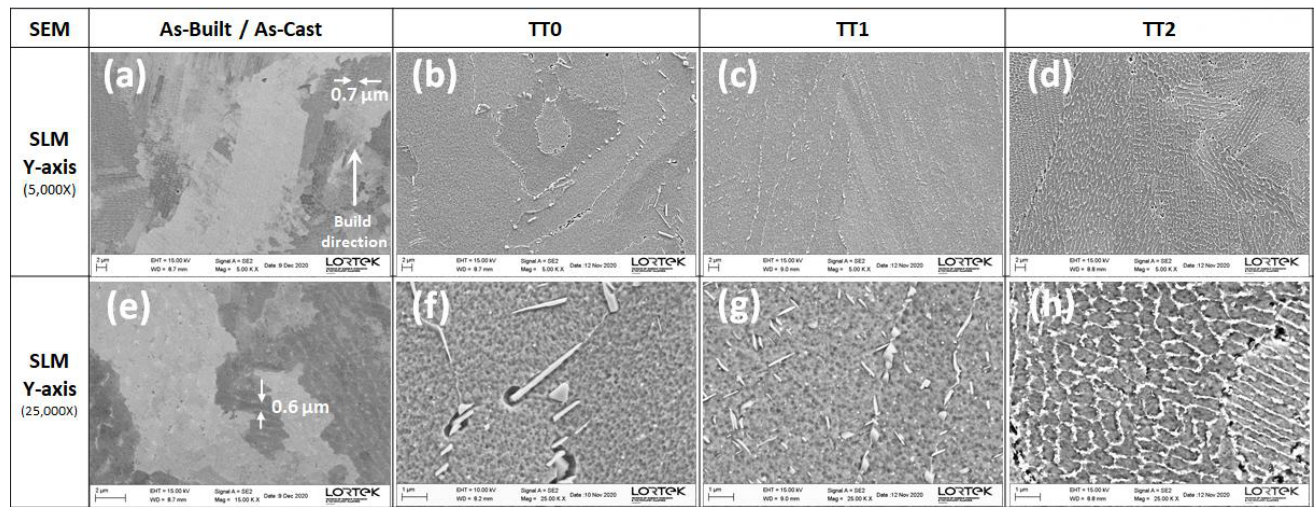
Figure 9. FESEM micrographs at different magnifications for IN718 SLMed in as-built and heat-treated conditions. ( a – d ): SLM samples in Y-axis, and ( e − h ): SLM samples in Z-axis. (all samples etched with Kalling Nº2).